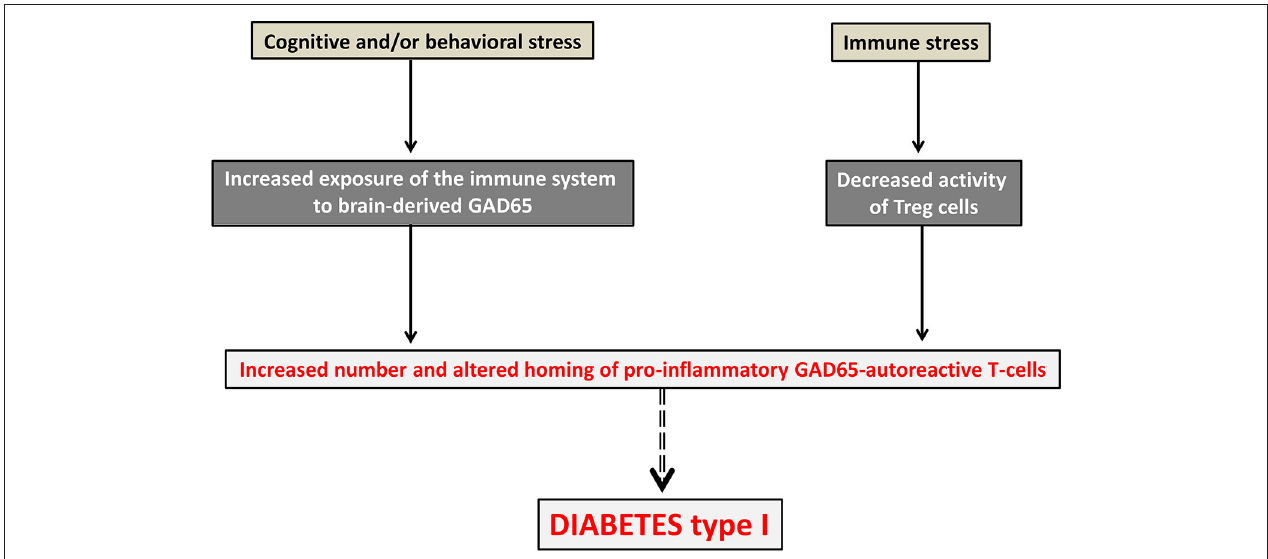
FIGURE 3 | Diabetes type 1 viewed as a neural disorder. In this pathophysiological scheme, pathological autoimmunity against GAD65, the main targeted autoantigen in diabetes type 1, would result from both immune and neural alterations occurring concurrently. An immune stress such as, for instance, a viral infection would lead to a drop of Tregs. In parallel, a cognitive or behavioral stress (for instance cognitive overstimulation or mood imbalance) would be responsible for an increased exposure of the immune system to the brain superautoantigen GAD65. Pathological autoimmunity against pancreatic islet cells expressing GAD65 antigen would then result from an increased number, increased activation state and altered homing of GAD65 autoreactive T-cells.